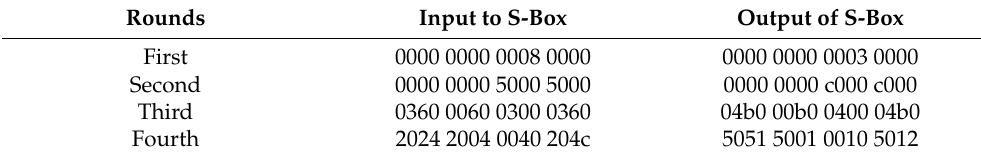
Table 3. Linear Characteristics for the SLA scheme.